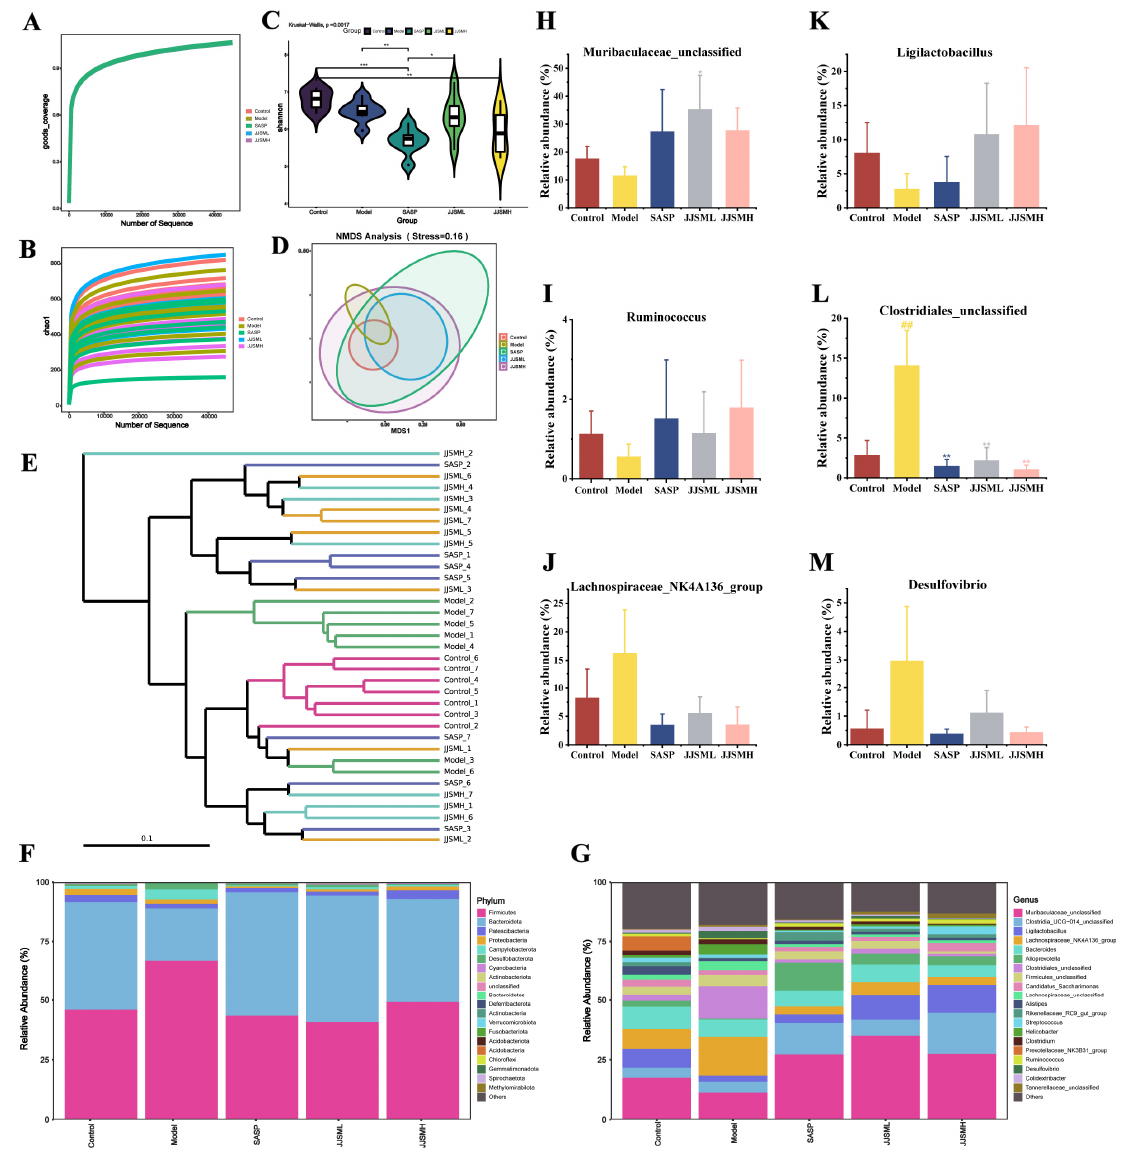
Figure 3. Analysis of microbial Alpha diversity. ( A ) Goods_coverage; ( B ) Chao 1 index and ( C ) Shannon index. Beta diversity: ( D ) Weighted NMDS analysis and ( E ) Weighted cluster tree analysis. Microbial community structure of each group: ( F ) Distribution of microbiome at phylum; ( G ) Distribution of microbiome at genus; ( H ) Relative abundance of Muribaculaceae_unclassified ; ( I ) Relative